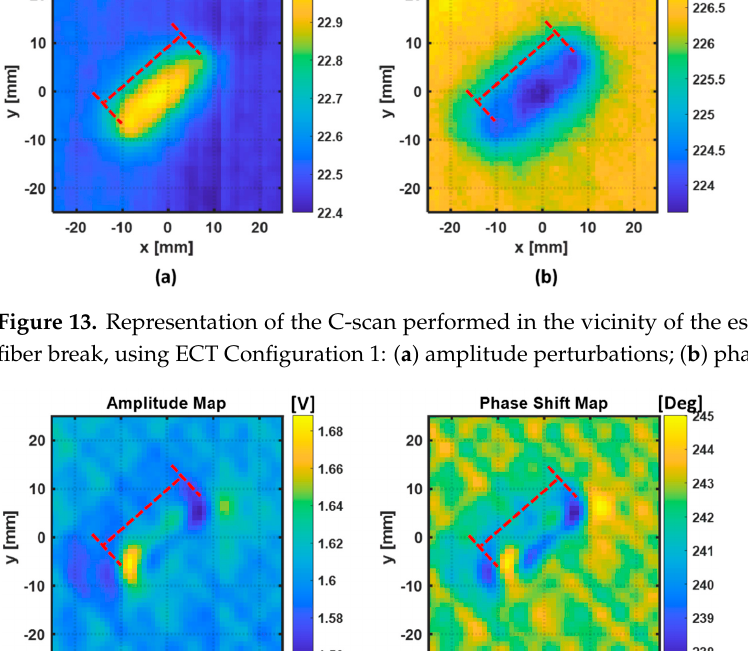
Table 4. Quantitative results of each ECT feature for the two excitation-probe